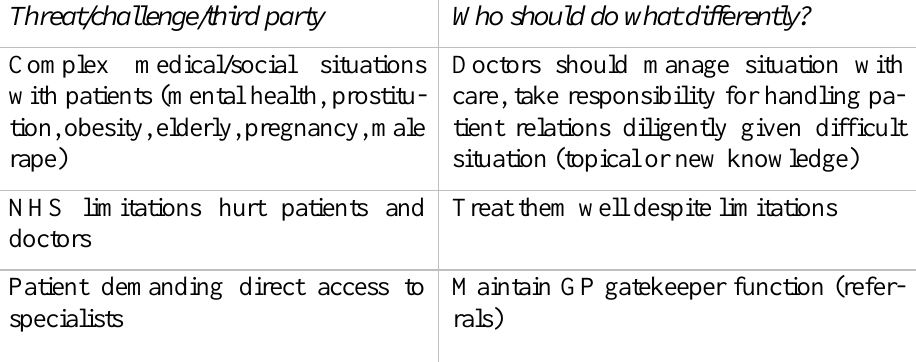
Table 3 UK doctors’ perceived threats to authority and proposed solutions Threat/challenge/third